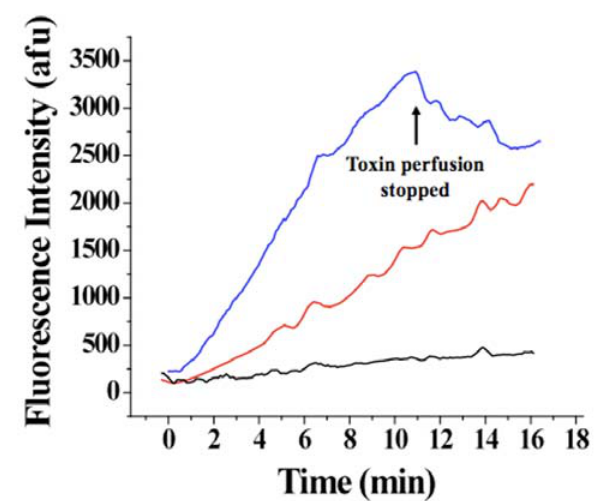
Figure 8. Evolution of Alexa-IpTxa fluorescence in three regions of interest. Blue, ROI-1, corresponding to the cell membrane and adjacent cytoplasm; Red, ROI-2 (bulk cytoplasm); Black, ROI-3